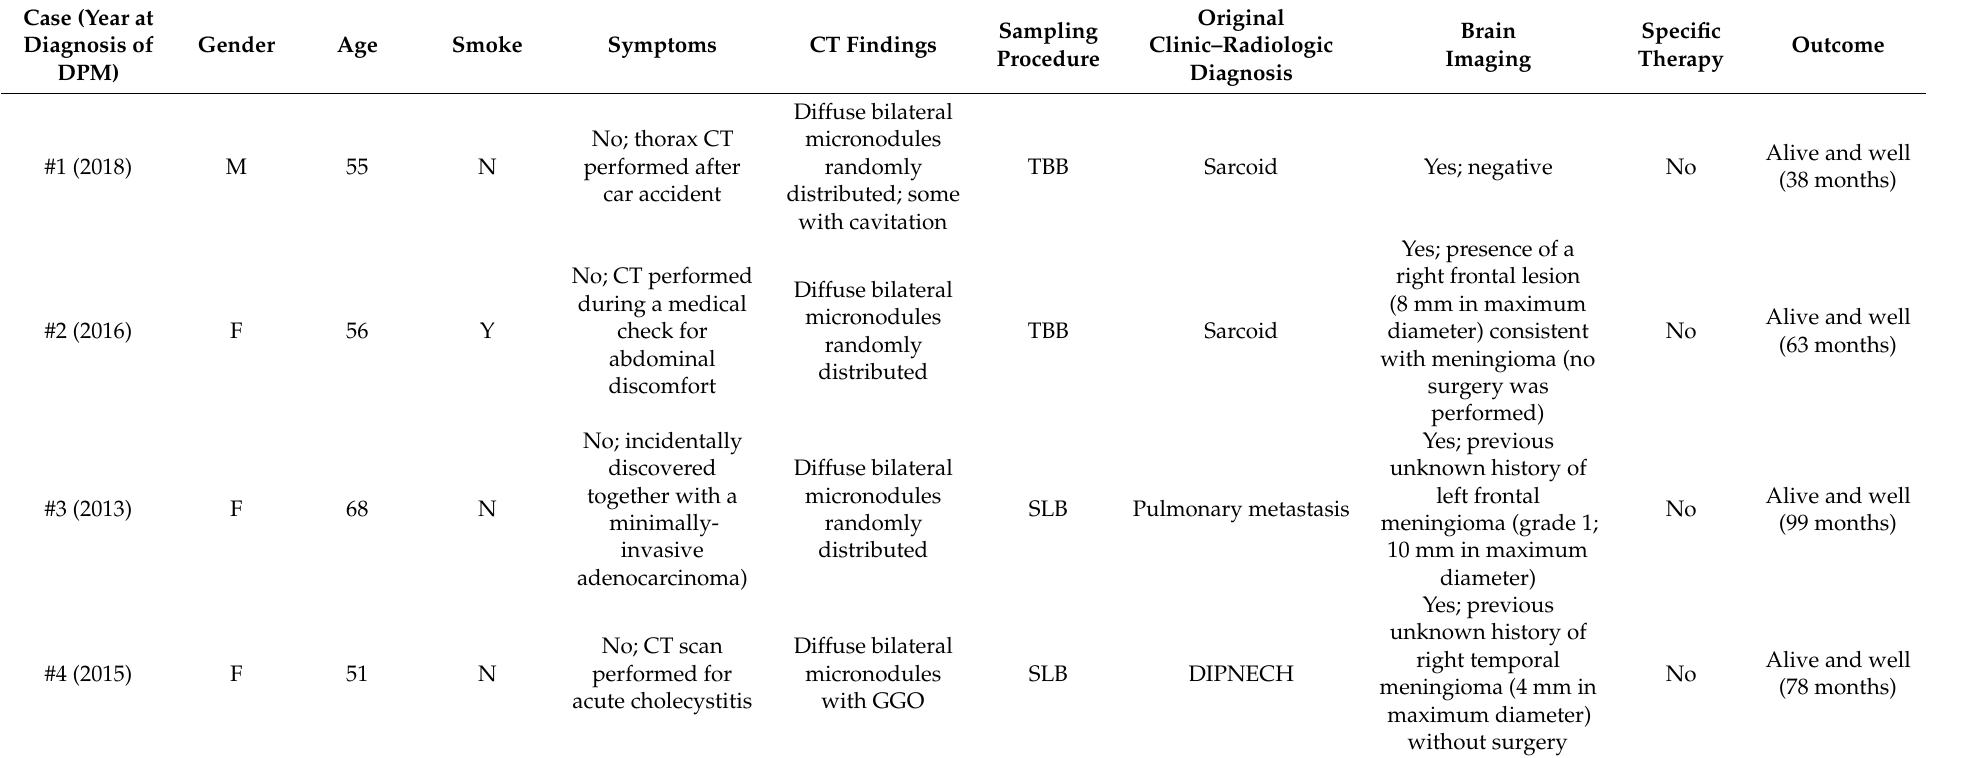
Table 1. Summary of the main clinical pathologic features of patients with diffuse pulmonary meningothelial nodules in this